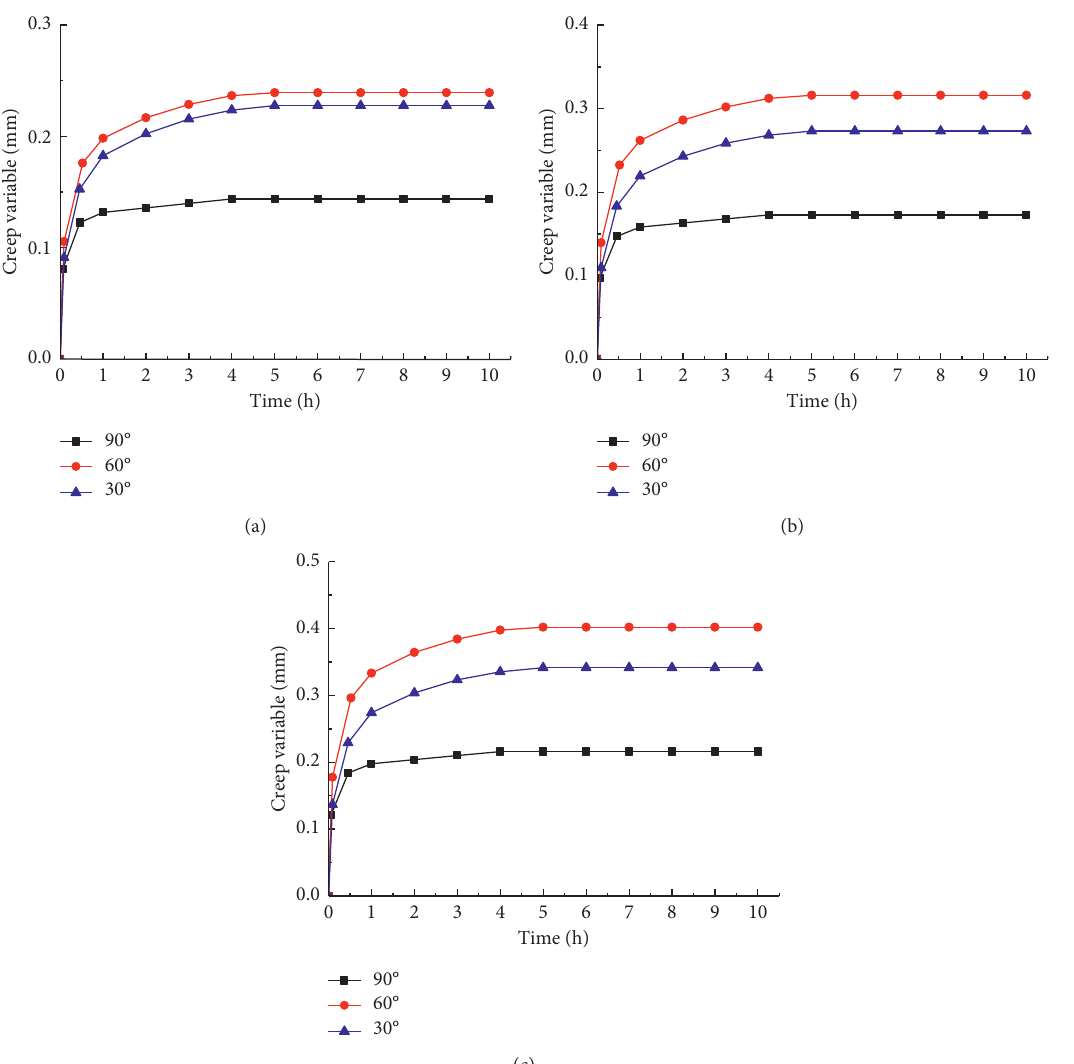
Figure 6: Transverse creep curve of anchored joint specimen. (a) The stress is 2MPa. (b) The stress is 4MPa. (c) The stress is 6